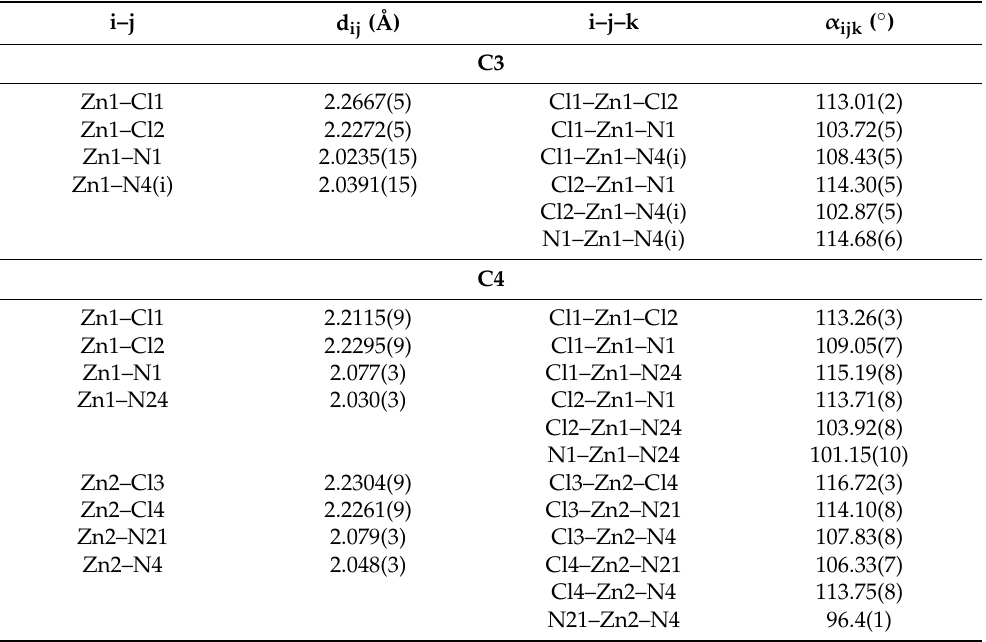
Figure 6. ( a , b ) Molecular structures of C3 and C4 with displacement ellipsoids of nonhydrogen atoms plotted with 50% probability ( a ). A comparison of the coordination entity structures ( b ). Table 5. Structural data of the coordination polyhedra in C3 and C4 .